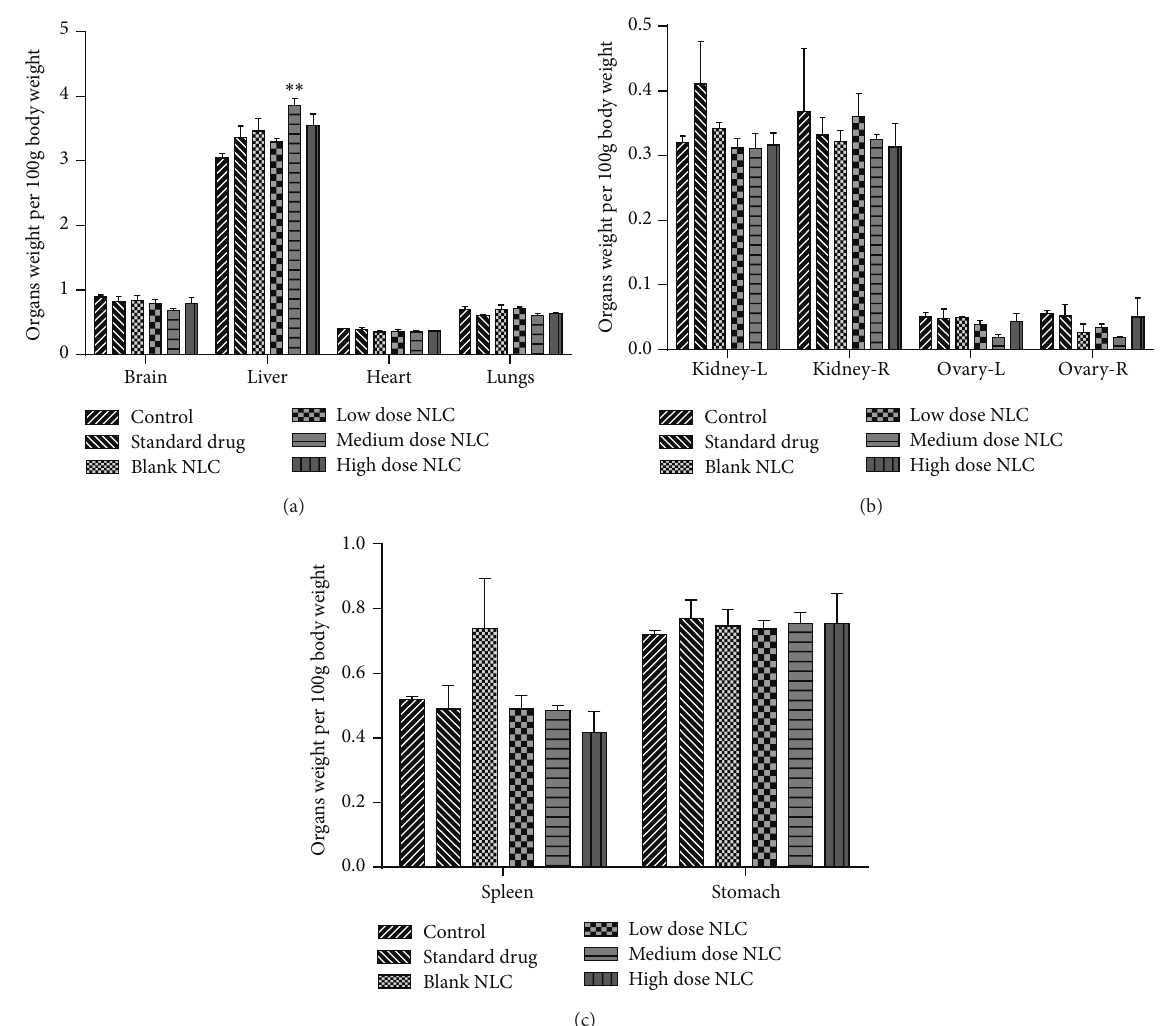
Figure 3: (a, b, and c) Organ weight of female rats treated with NLCs formulation. All the values are represented as mean ± SEM and 𝑛 = 5 . ∗∗ 𝑝 < 0.01 . Kidney-R: right kidney, Kidney-L: left kidney, Ovary-R: right ovary, and Ovary-L: left ovary.